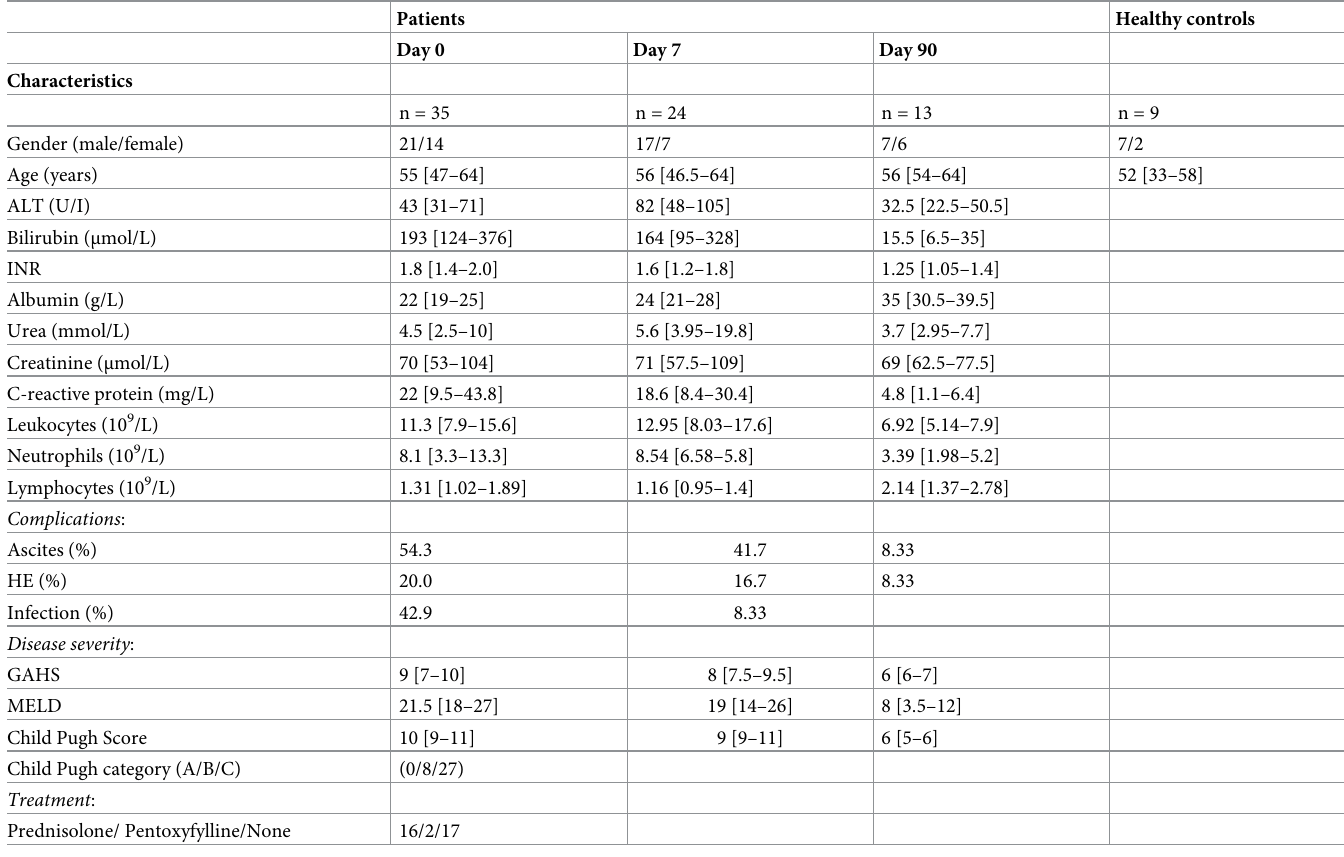
Table 1. Characteristics. Patients Healthy